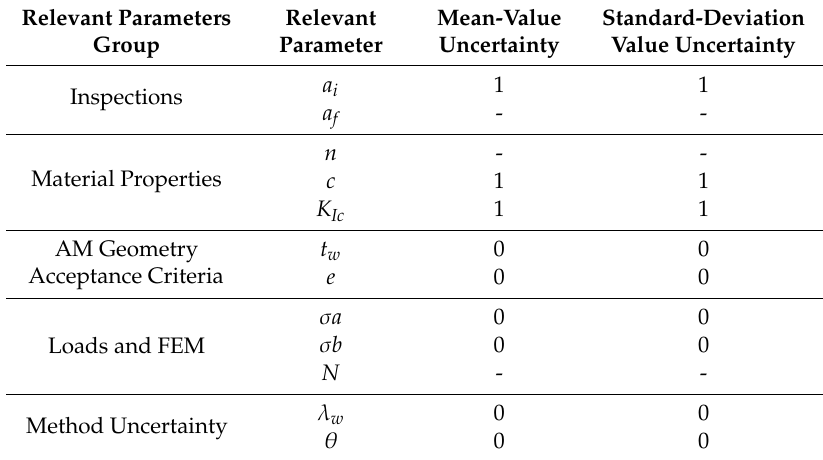
Table 7. Parameters uncertainty